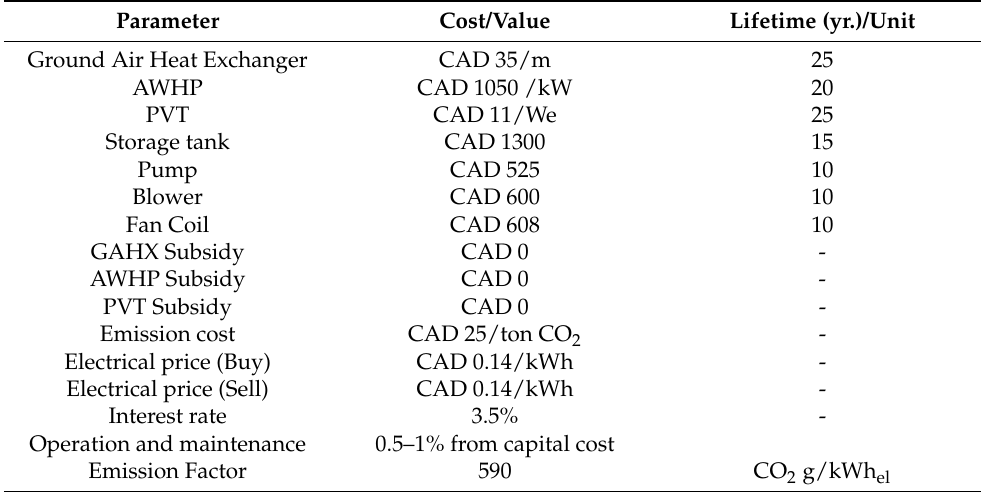
Table 3. Economic and emissions input parameters.